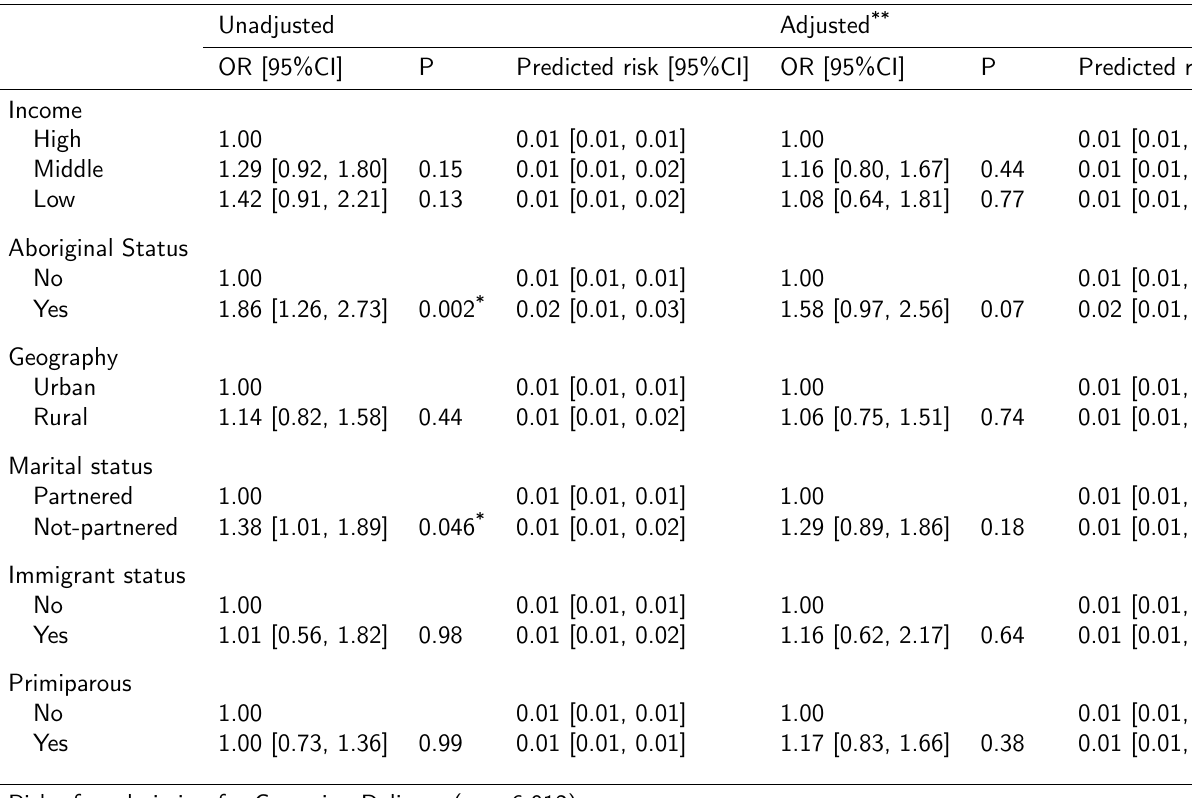
Table 5: Odds ratios and risks of maternal admission within 30 days before delivery Risk of readmission for vaginal delivery (n =